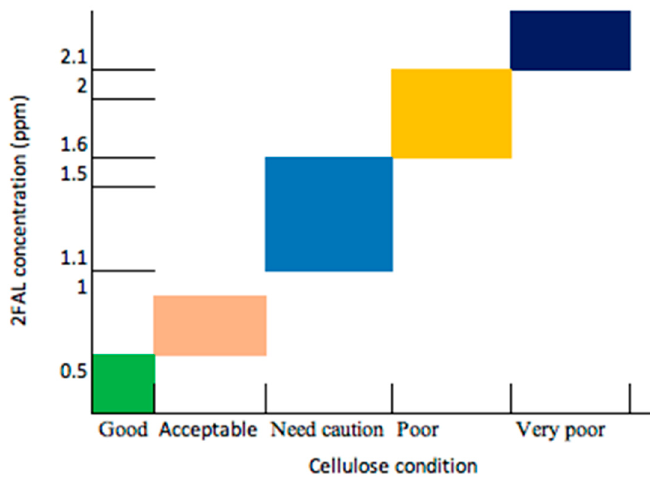
Figure 2. Transformer condition based on 2FAL concentration (ppm).